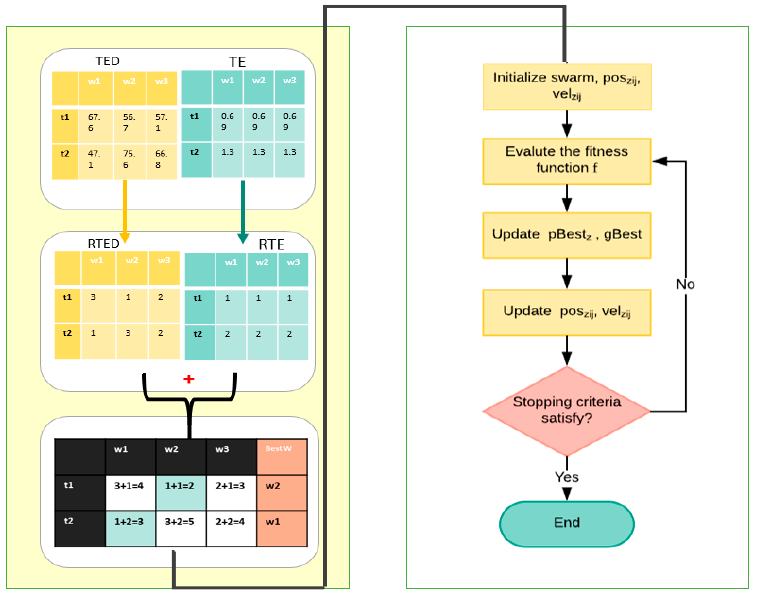
Figure 3. The procedure of the multi-objective task scheduling optimization (MOTSO) model. TED = task execution duration table; TE = task entropy table; RTED = ranked TED; RTE = ranked TE; w1 = first worker; w2 = second worker; w3 = third worker; t1 = first task; t2 = second task.